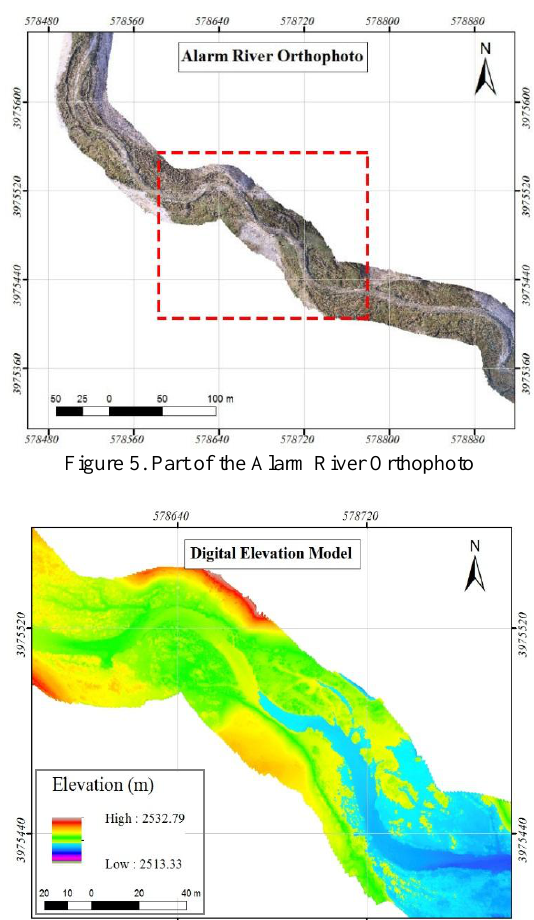
Figure 6. DEM of the red dashed rectangle as shown in figure 5